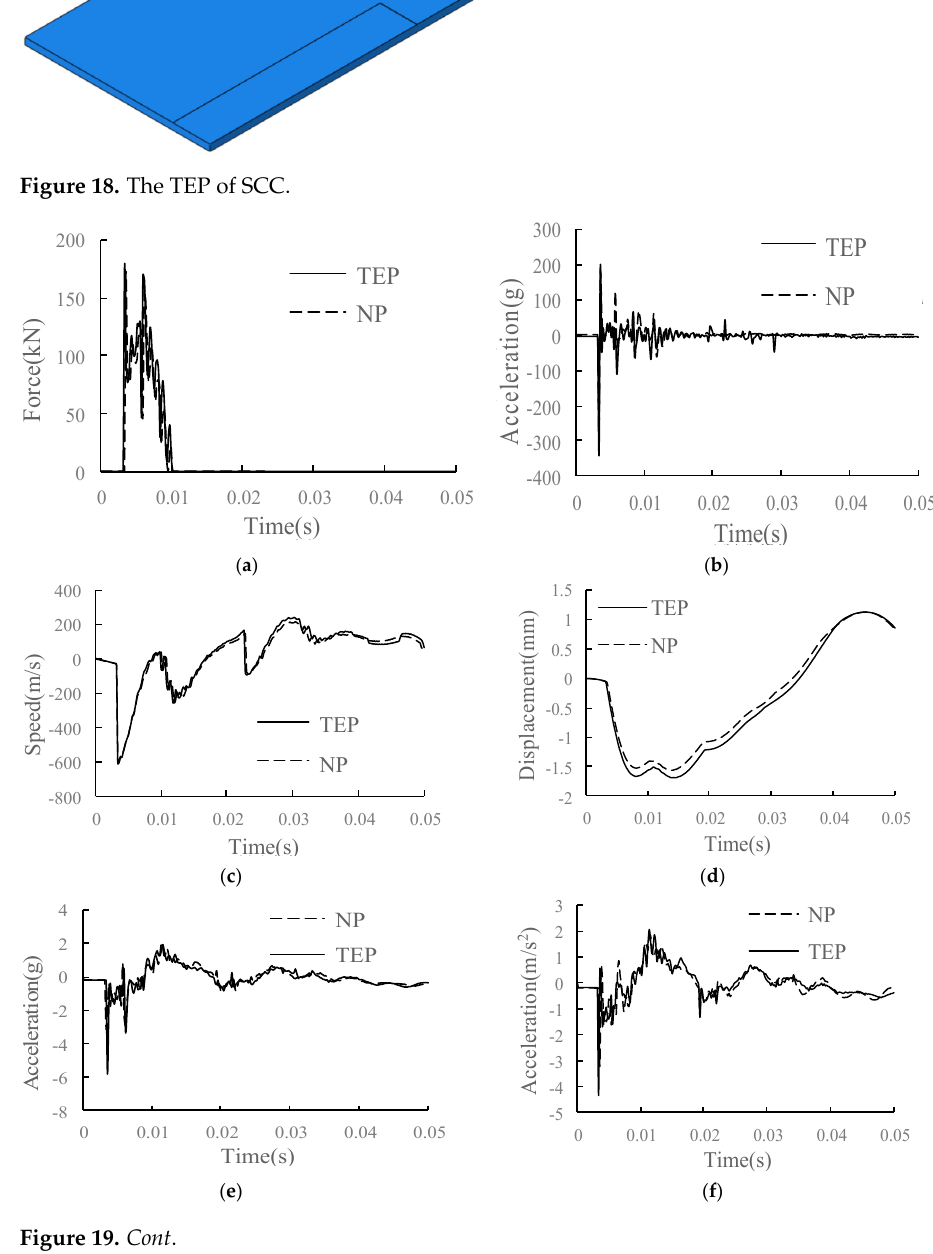
( j ) Figure 19. Dynamic response diagram of each structural layer in the condition of TEP: ( a ) wheel– rail vertical force; ( b ) rail acceleration; ( c ) rail vertical speed; ( d ) rail vertical displacement; ( e ) track slab acceleration; ( f ) acceleration of SCC layer; ( g ) longitudinal stress of SCC layer; ( h ) vertical stress of SCC layer; ( i ) base acceleration; ( j ) vertical stress of substructure.